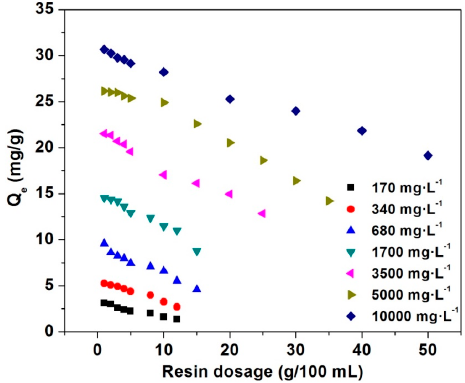
Figure 4. Iron adsorption capacity of resin Rexp-501 at various iron concentrations, 298 K.